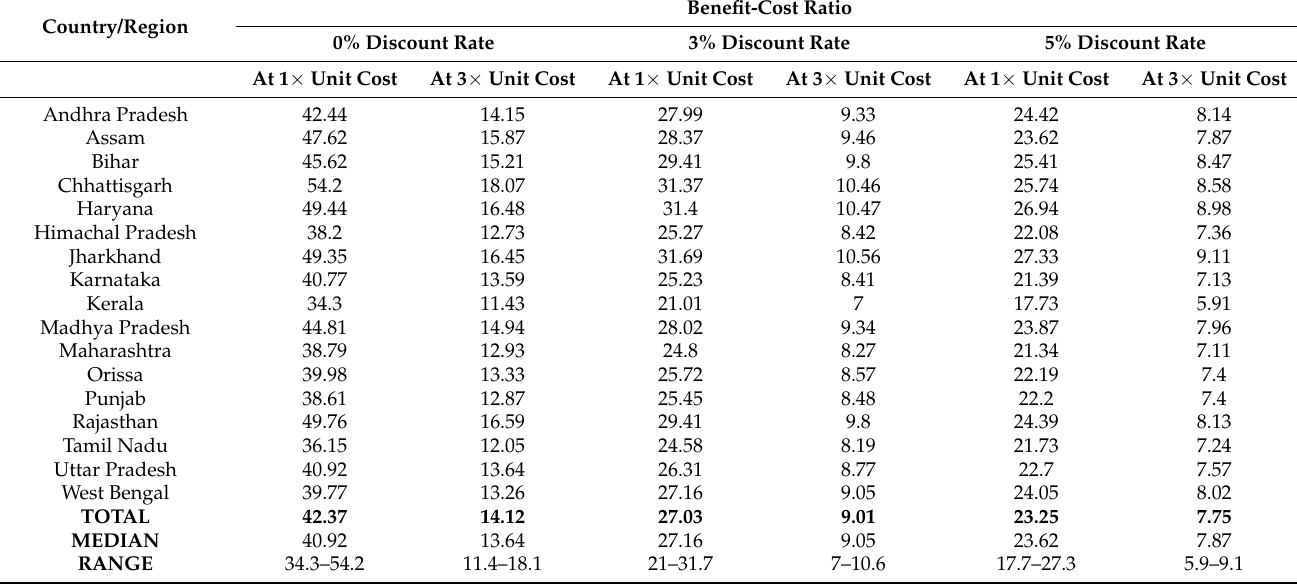
Table A5. Sensitivity analysis: cost–benefit ratio at 0%, 3%, and 5% and 1 × and 3 × unit cost (0.37 USD): 17 Indian states.